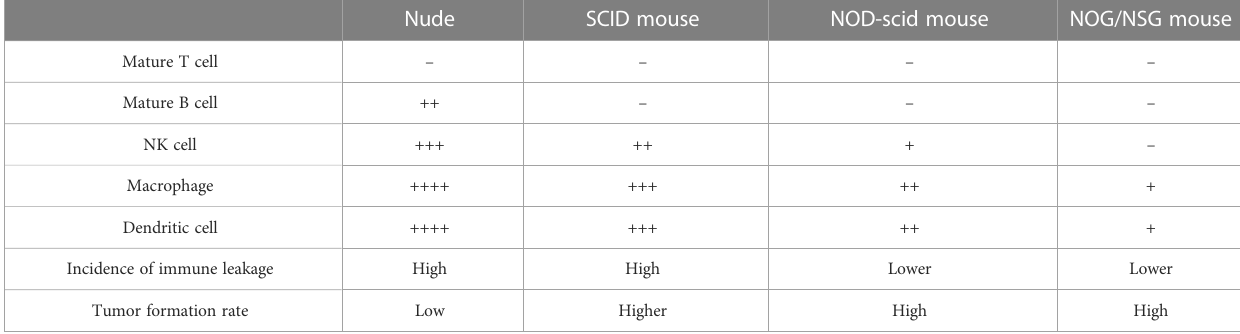
TABLE 1 Comparison between immunized